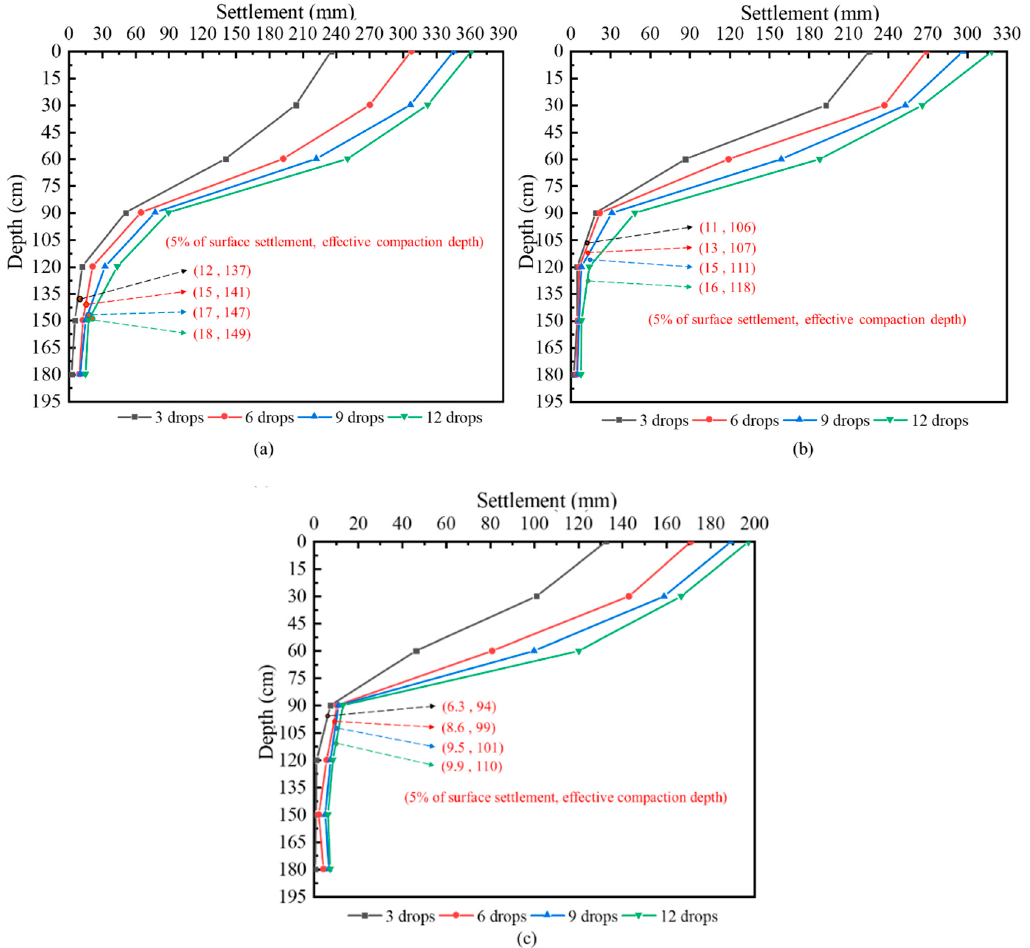
Figure 10. Layered settlement of soil: ( a ) condition 1; ( b ) condition 2; ( c ) condition 3.